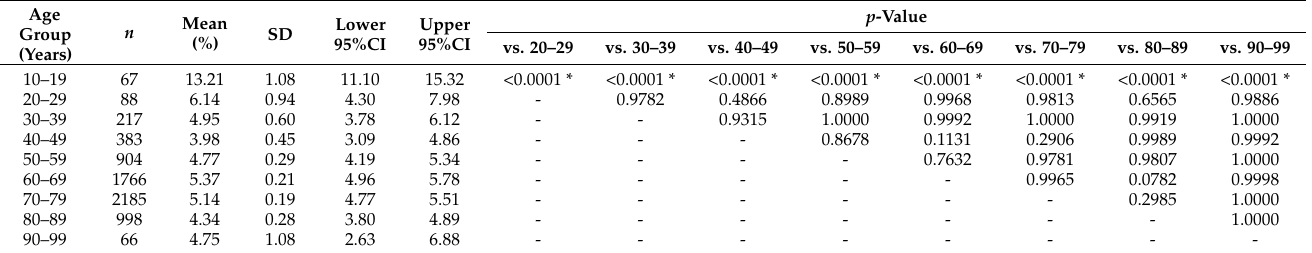
Table 3. FL stratified by age.